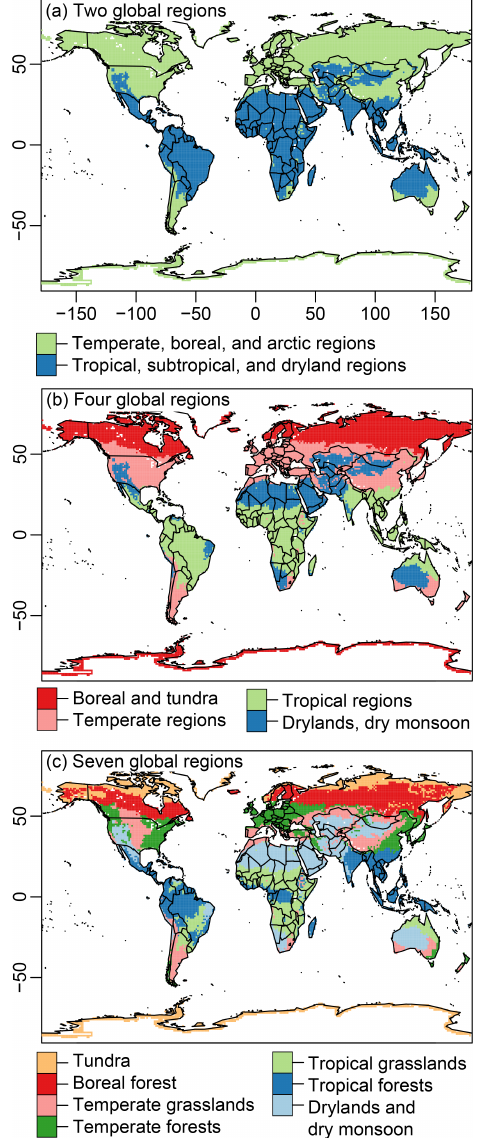
Figure 2. The two hemispheric regions (a) , four continental re- gions (b) , and seven biome-based regions (c) used in this study. These regions are based upon the world biome map by Olson et al. (2001). The two- and four-region maps are constructed by aggregat- ing individual biomes into larger